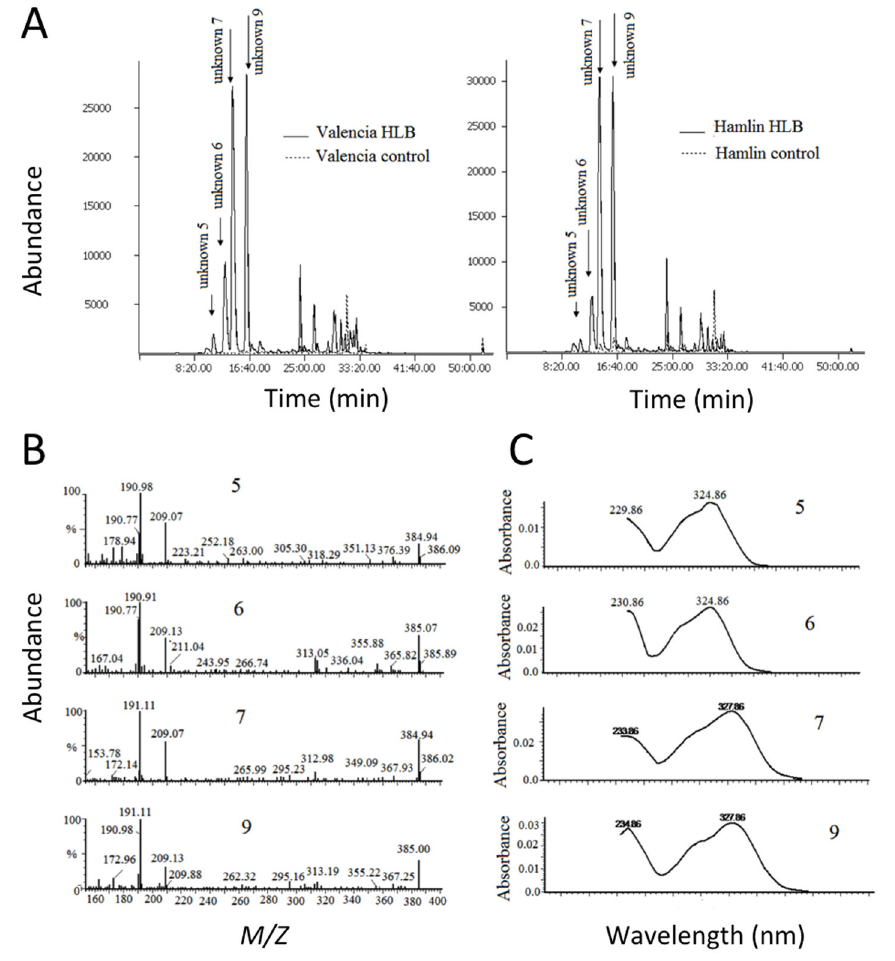
Figure 3. Typical APCI-HPLC-MS chromatograms of ‘Hamlin’ and ‘Valencia’ leaf extracts and mass-spectra and UV spectra of unknown 5, 6, 7, and 9. A) selective ion recording chromatograms of “ m/z ” specie of 177 in the positive ion mode; B ) negative electrospray ionization mass spectra ; C ) UV spectra of unknown 5 , 6 , 7 , and 9 . doi: